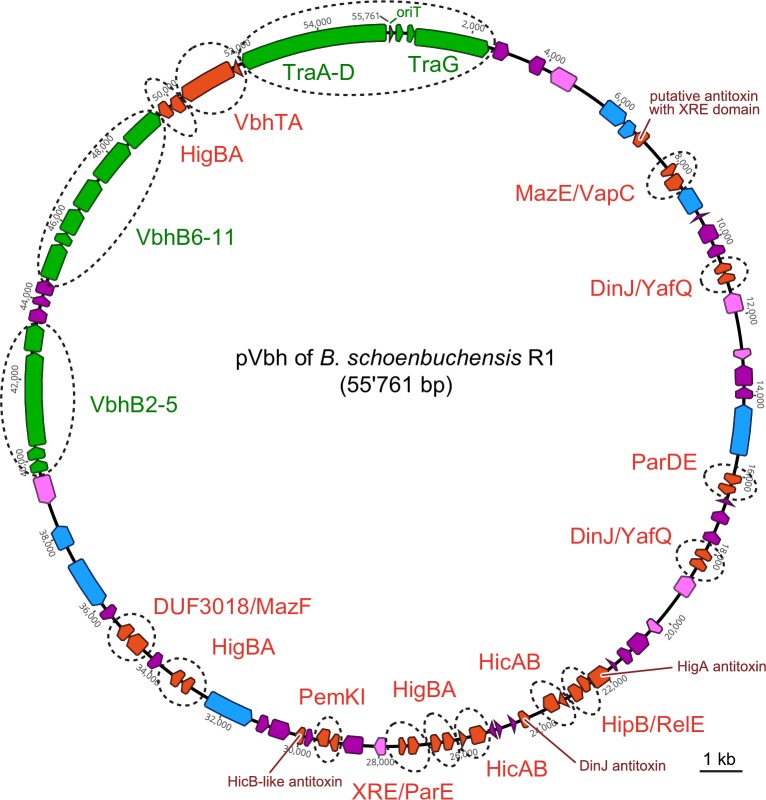
pVbh encodes a multitude of TA modules but lacks any recognizable cargo genes.All genes on pVbh of B. schoenbuchensis R1 (genbank accession number CP019790.1) were manually annotated and categorized as belonging to the Vbh conjugation system (green; see also Fig 2), plasmid replication and partitioning functions (light blue), TA modules (red), or as encoding proteins of unknown function with (light pink) or without (dark pink) known protein domains. The fourteen predicted TA modules and four orphan antitoxins as well as the loci encoding the Vbh T4SS (VbhB2-11), Dtr functions (TraA-D), and T4CP (TraG) were highlighted in detail. Annotations of every gene on pVbh are available in S1 Fig.